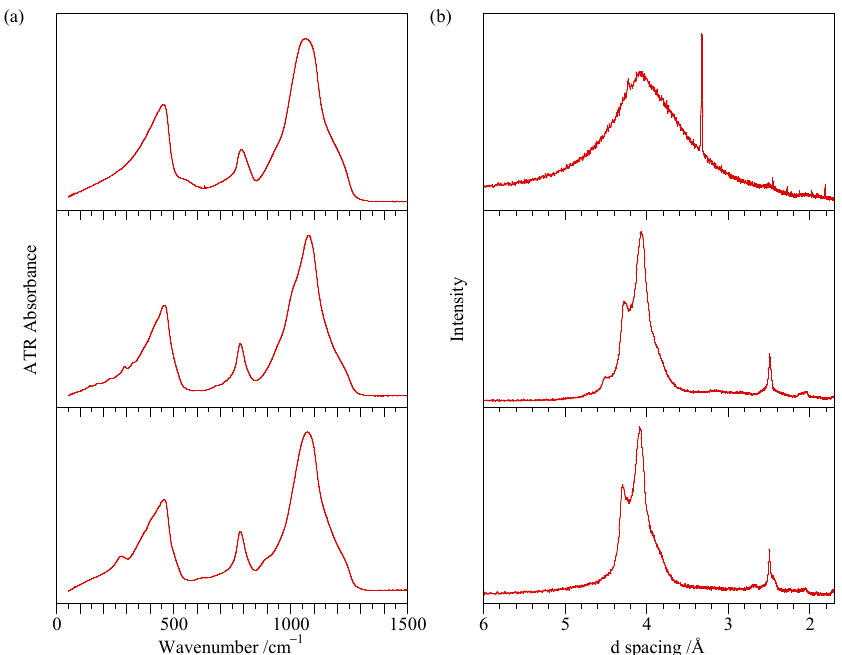
Figure A3. Characterisation of samples showing “impurities” in their XRD pattern ( a ) ATR spectra of finely ground samples and ( b ) XRD pattern. In ascending order, G13743 (opal-CT from Siebengebirge, Germany), G NEW04 (opal-CT from Mt Lyobo Tanzania) and G14581 (transitioning opal-A to opal-CT from Andamooka,